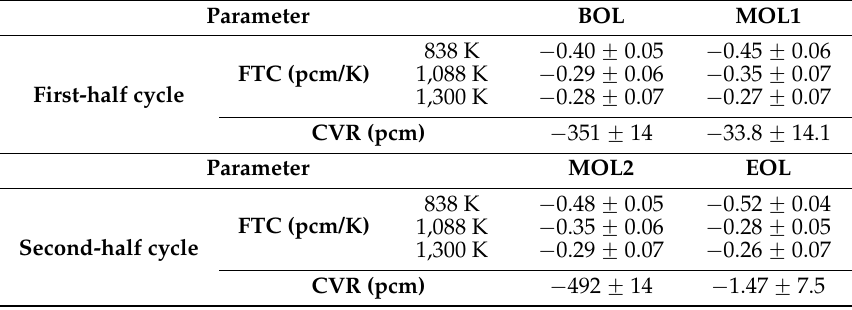
Table 6. Fuel temperature coefficient (FTC) and coolant void reactivity (CVR) of the MMR core.